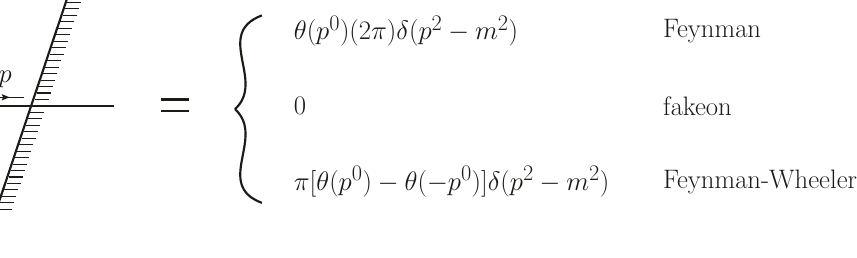
Figure 2 . Cut propagators in the various